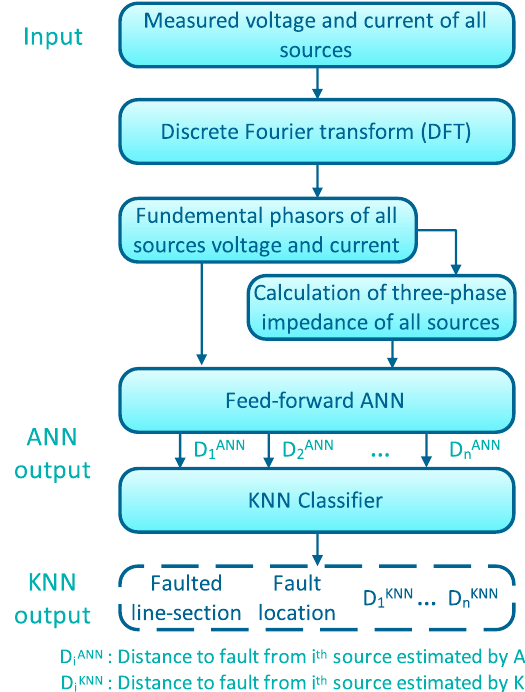
Fig. 1 A typical multi-layered perceptron (MLP) neural network with two hidden layers Fig. 2 Architecture of the proposed